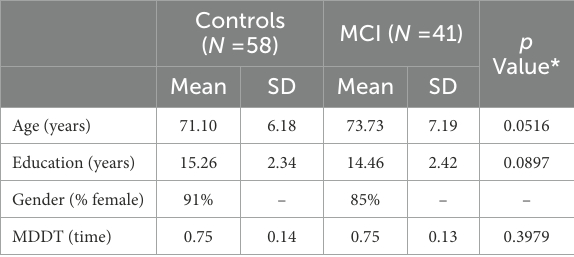
TABLE 1 Demographic characteristics and discrimination task of control and MCI subject